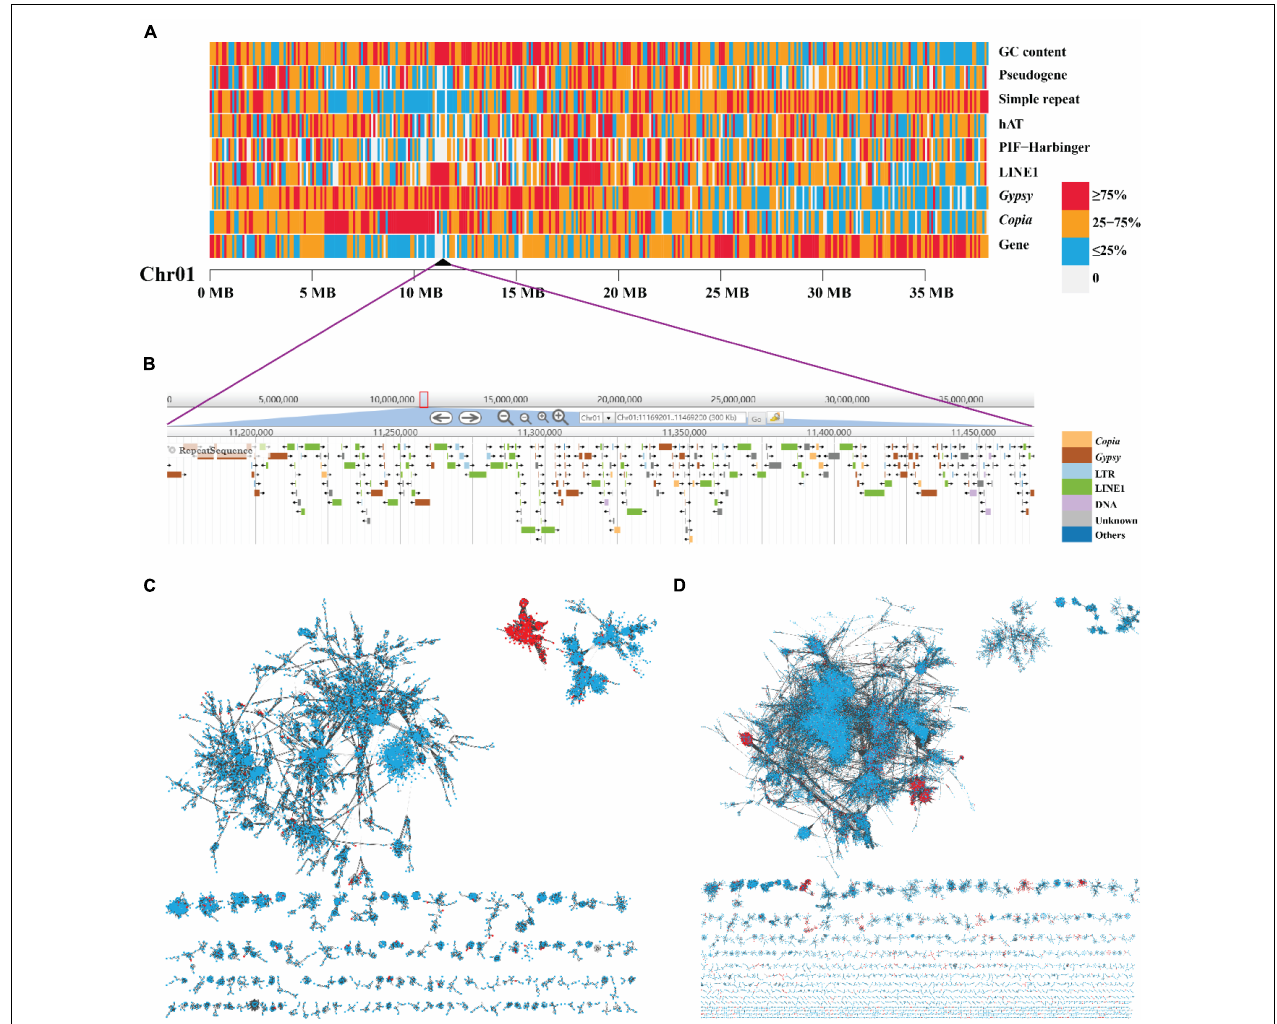
FIGURE 4 | The high enrichment of LINE1 and Gypsy elements and their independent accumulation in the centromere of Chromosome 1. (A) A heat map view of protein-coding genes, TE ( Copia , Gypsy , LINE1, PIF-Harbinger, and hAT), simple repeat, pseudogene, and GC content density in 100-Kb non-overlap sliding windows along chromosome 1 “Chr01.” The black triangle represents the predicted location of centromere. (B) The zoom in on the centromeric region. (C,D) The phylogenetic network of LINE1 and Gypsy elements, respectively. Each node in the network represents a single element. The links were defined as blast + alignment “bitscore” values (red, element in centromeric regions; blue, element in non-centromeric